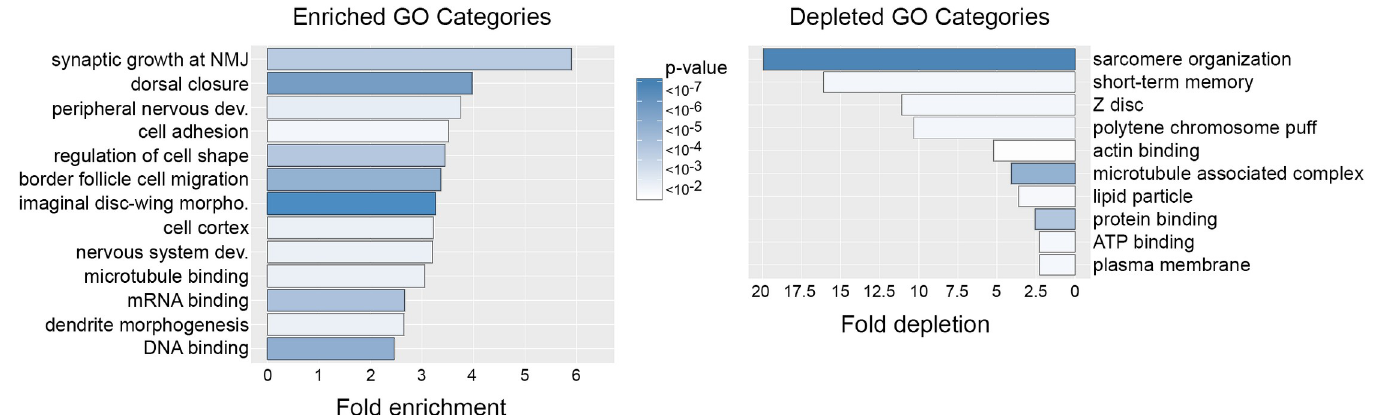
Fig 3. Gene ontology of enriched and depleted transcripts. GO categories over-represented among EC-RNA enriched and depleted genes. Observed / expected value = frequency of category genes in EC-RNA / frequency in the Drosophila genome. Heatmap = Bonferroni-corrected P-values. NMJ = neuromuscular junction.